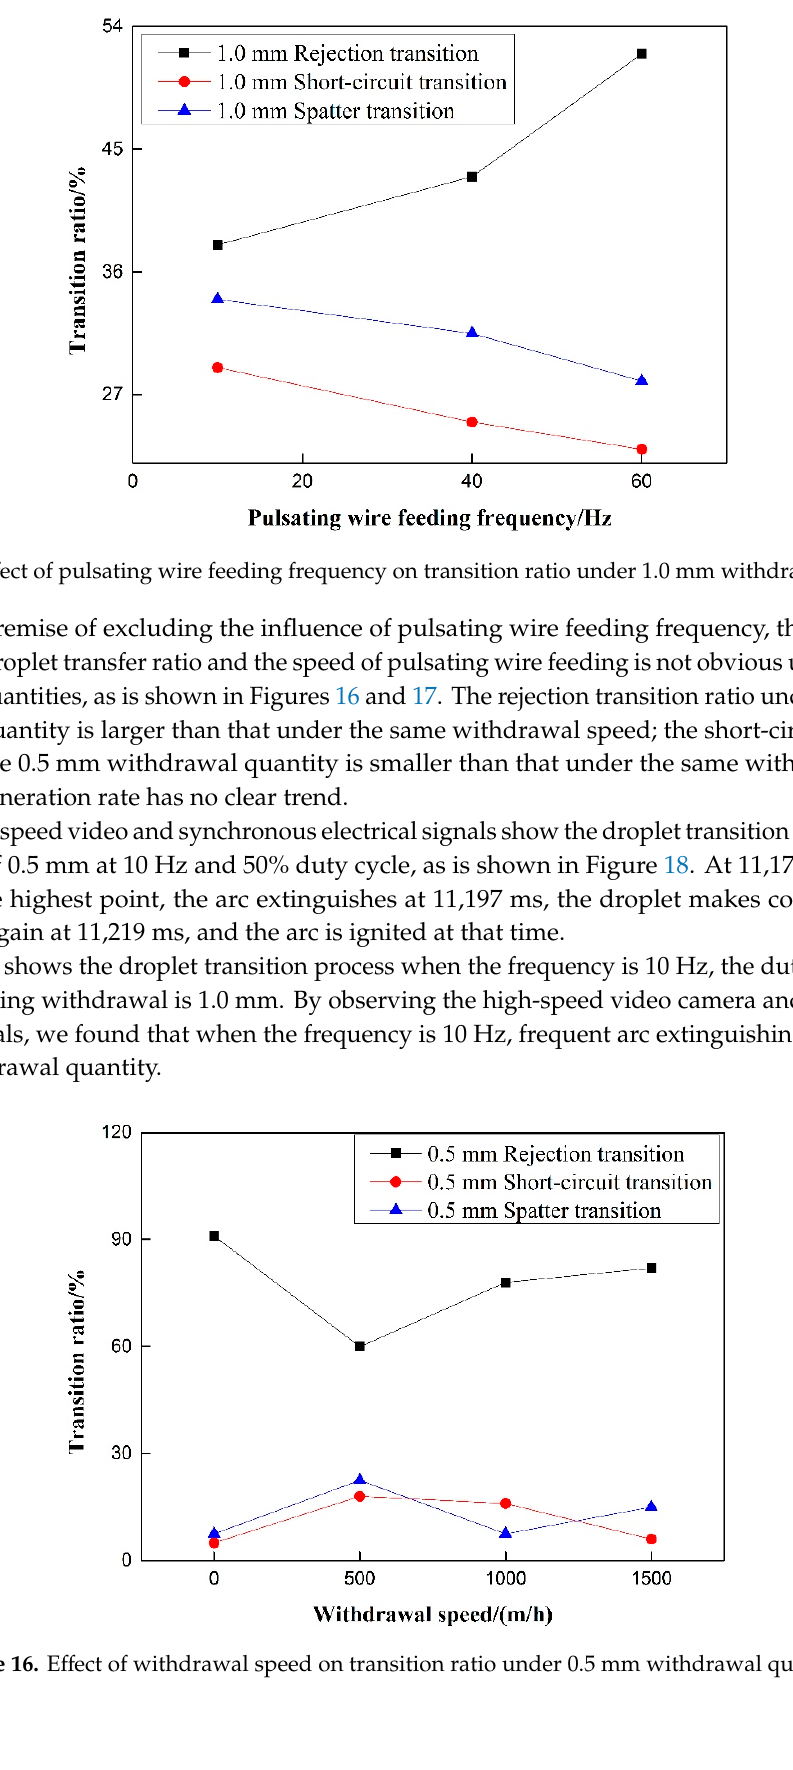
Figure 14. Effect of pulsating wire feeding frequency on transition ratio under 0.5 mm withdrawal quantity.